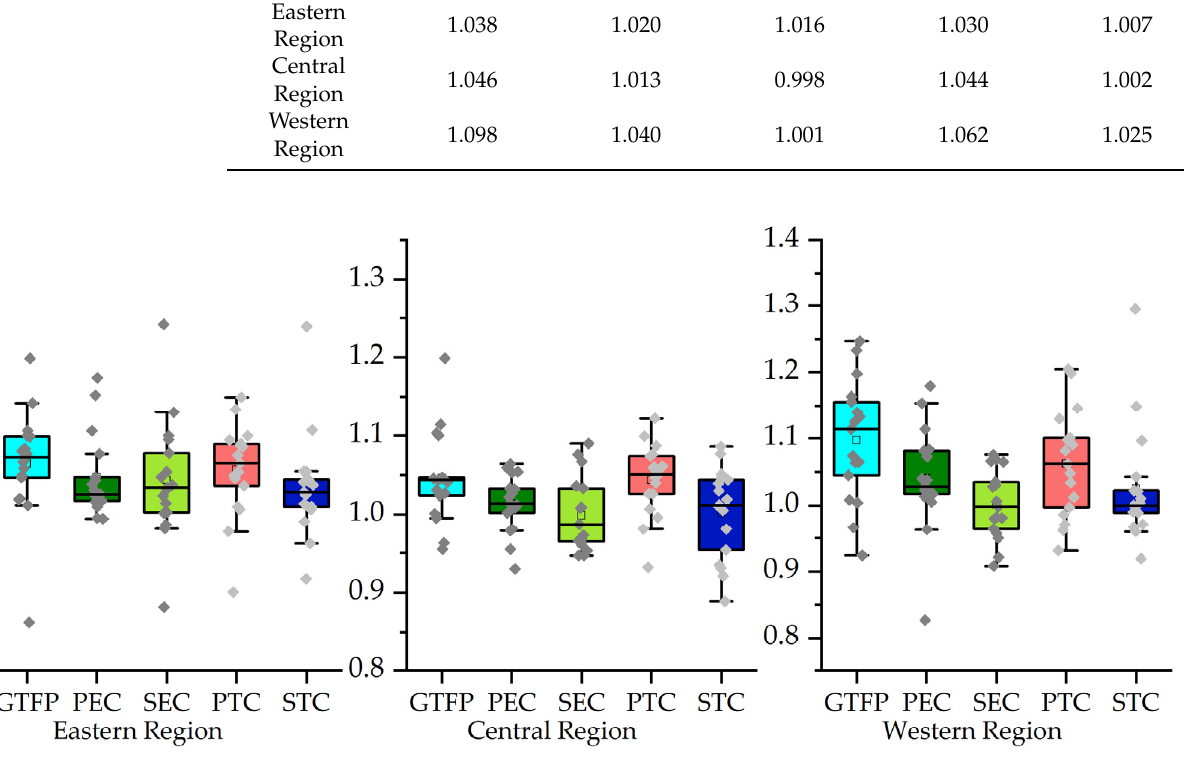
Table 4. FGTFP and Zofio index decomposition of mariculture in three regions, 2003–2020.